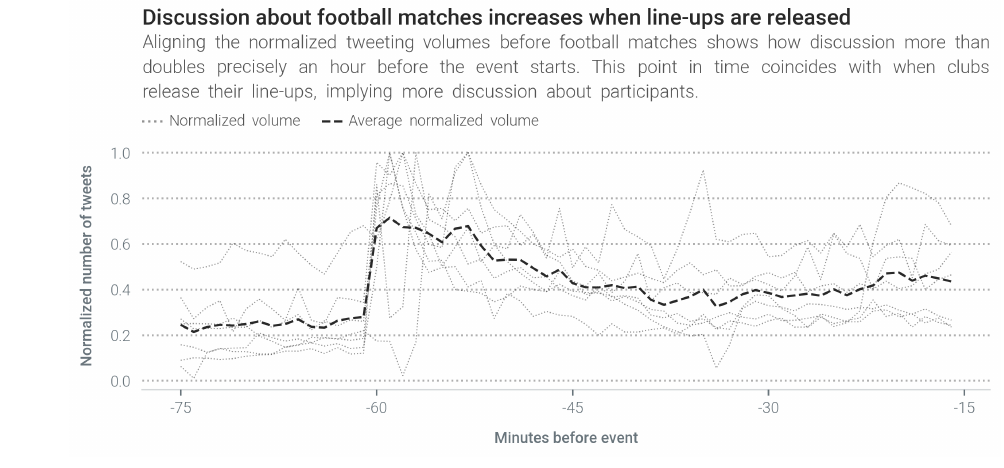
Figure 3. Discussion increases immediately after football clubs release their